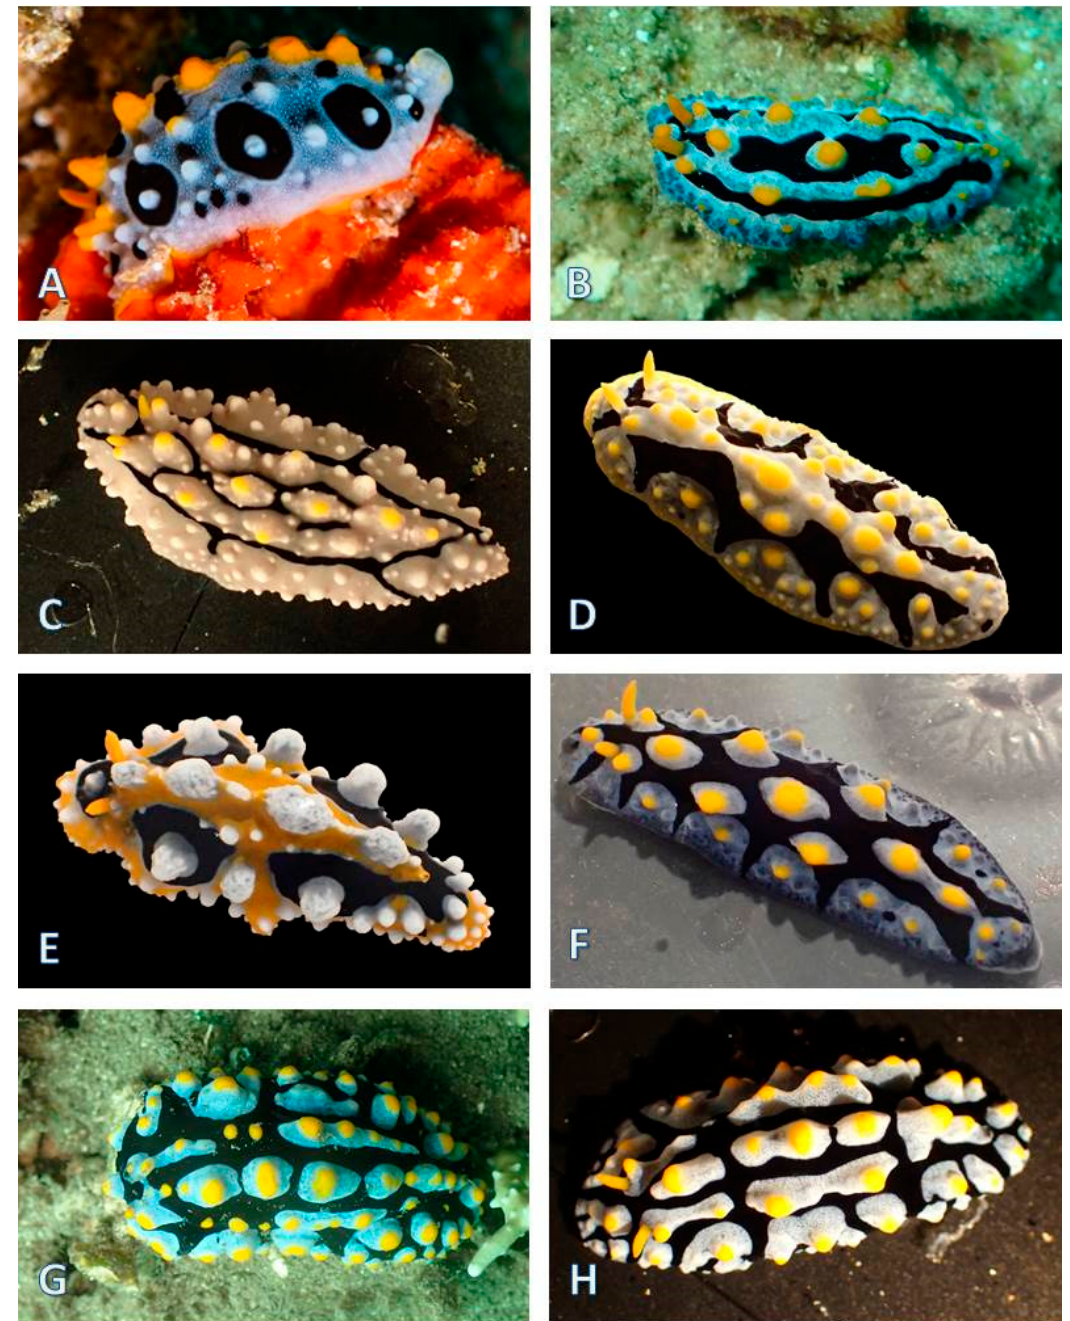
Figure 16. Nudibranchia Doridina: ( A ) Phyllidia cf. babai *; ( B ) Phyllidia coelestis , Phco18Ba-1; ( C ) Phyllidia elegans , Phel18Ba-1; ( D ) Phyllidia exquisita , Phex17Ba-1; ( E ) Phyllidia ocellata , Phoc17Ba-1; ( F ) Phyllidia picta , Phpi17Ba-1; ( G , H ) Phyllidia varicosa , Phva18Ba-11, Phva18Ba-6. *Specimen not collected.